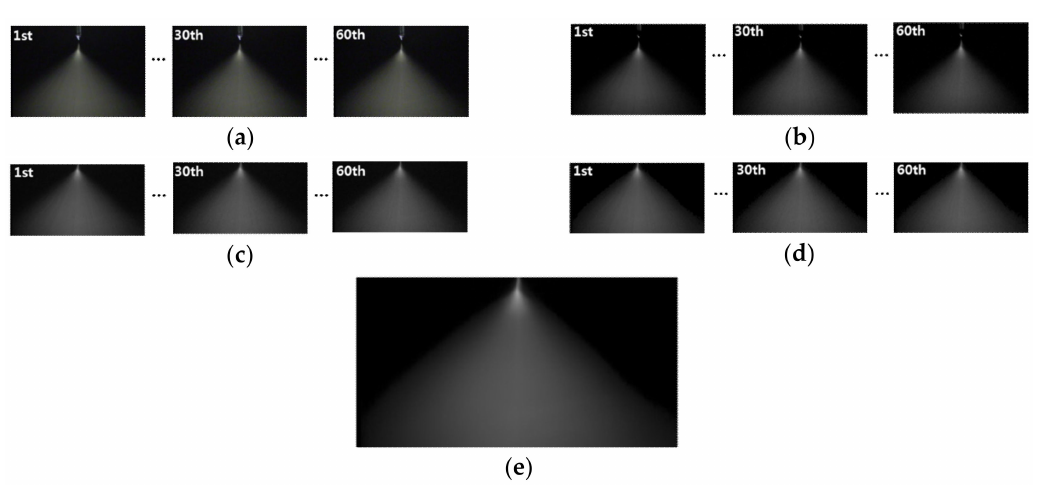
Figure 5. Example of analyzing the spray pattern at the electric field of 15 kV and the pneumatic pressure of 0.0 bar. One representative image was obtained from a series of sixty images in each process condition. ( a ) RGB images; ( b ) gray-scale image; ( c ) cropped images; ( d ) noise canceled images; ( e ) averaged